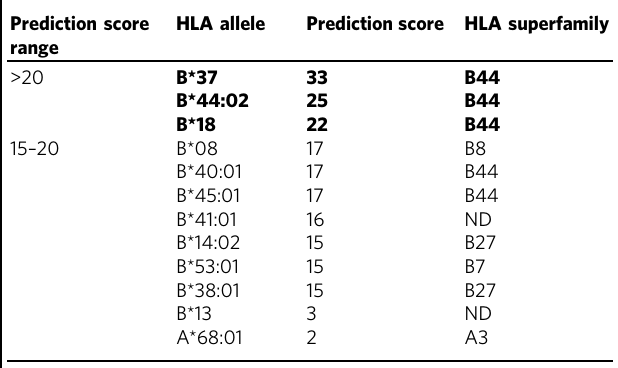
Table 1 HLA alleles predicted to bind the WT NP 338 – 346 FEDLRVLSF peptide Prediction score